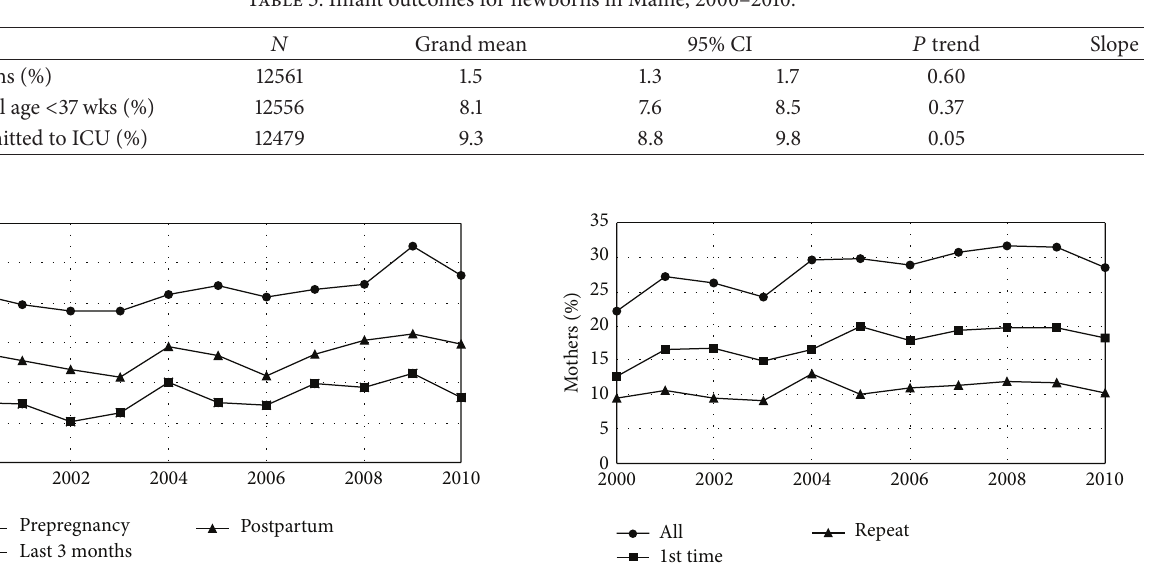
Figure 3: Maternal smoking by year. Fraction of mothers who smoked cigarettes in the last 3 months before pregnancy, the last 3 months of pregnancy, and postpartum (at the time of the questionnaire) for women giving birth in Maine by year. Healthy People 2020 has objectives of a 10% increase in the percent of women who did not smoke cigarettes prior to pregnancy as well as a 10% increase in abstinence from cigarettes among pregnant women. Maine is not moving toward this goal.